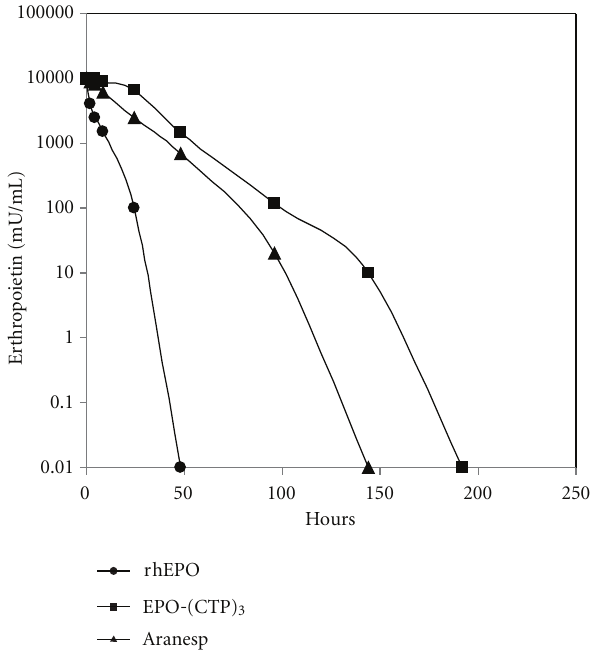
Figure 7: In vivo half-life of EPO variants. Mice were injected IV with 20IU of rHuEPO, Aranesp and EPO-(CTP) 3 and blood samples were drawn at the indicated times. Serum levels of EPO were determined by RIA. Mean ± SE of 5 determinations. Basal EPO levels before treatment were